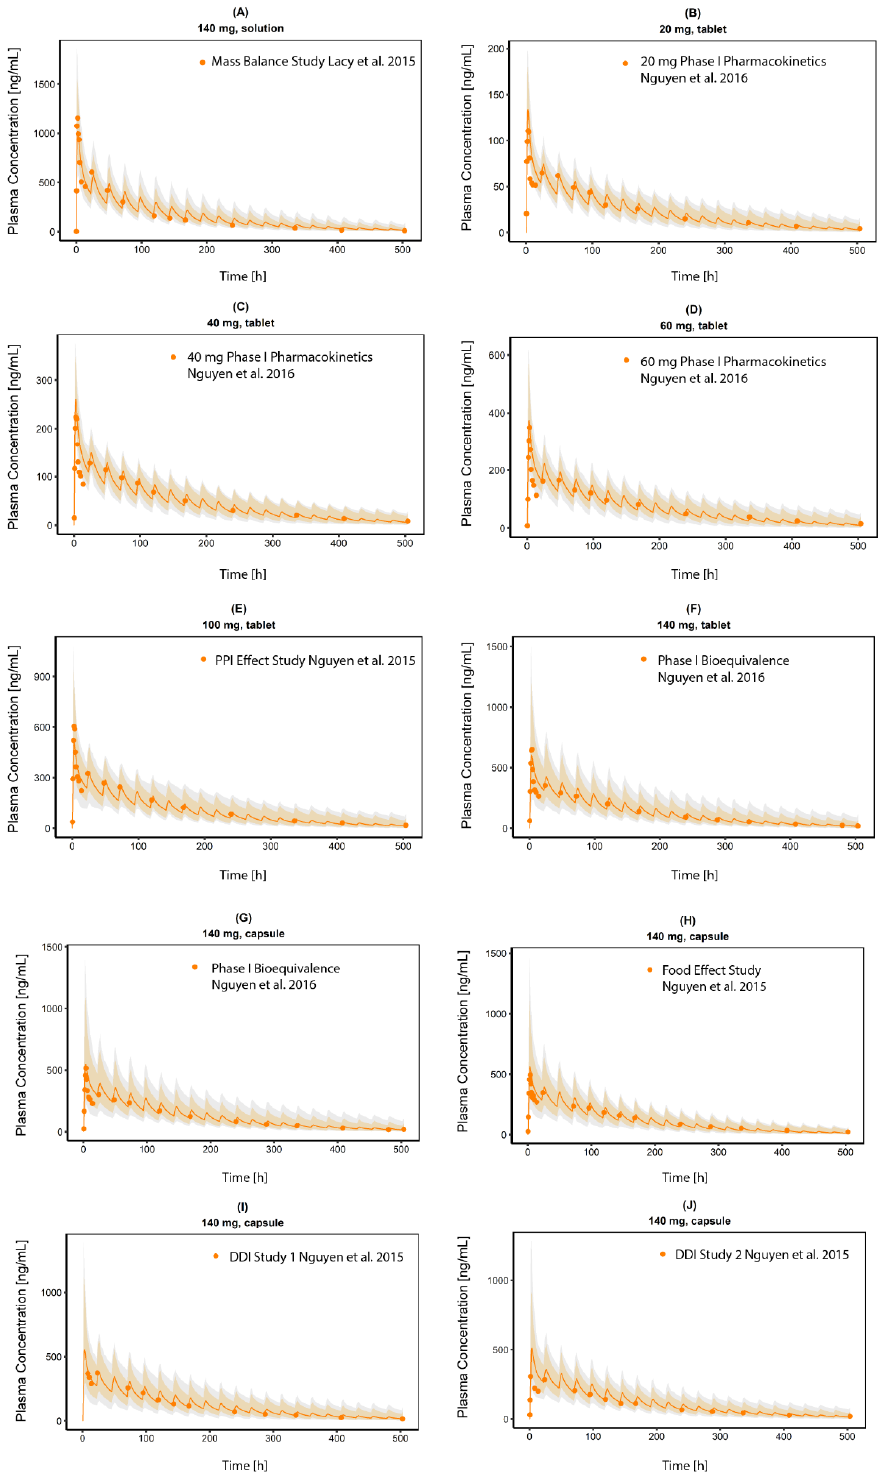
Figure 4. CAB plasma concentration time profiles (linear). ( A ) 140 mg CAB oral solution from a mass balance study, ( B – D ) data from a Phase I study CAB as tablet in 20, 40 and 60 mg oral single dose, ( E ) CAB 100 mg oral single dose as tablet in a PPI effect study, ( F , G ) 140 mg CAB as tablet an capsule formulation from a bioequivalence study, ( H ) 140 mg CAB oral single dose as capsule formulation from a food effect study, ( I , J ) 140 mg CAB oral single dose as capsule formulation from DDI studies with Ketoconazole and Rifampin. Observed data are shown as orange dots. Population simulation ( n = 100) geometric means are shown as orange lines; the shaded orange areas represent the predicted population geometric SD. The shaded grey areas represent the 5% to 95% prediction